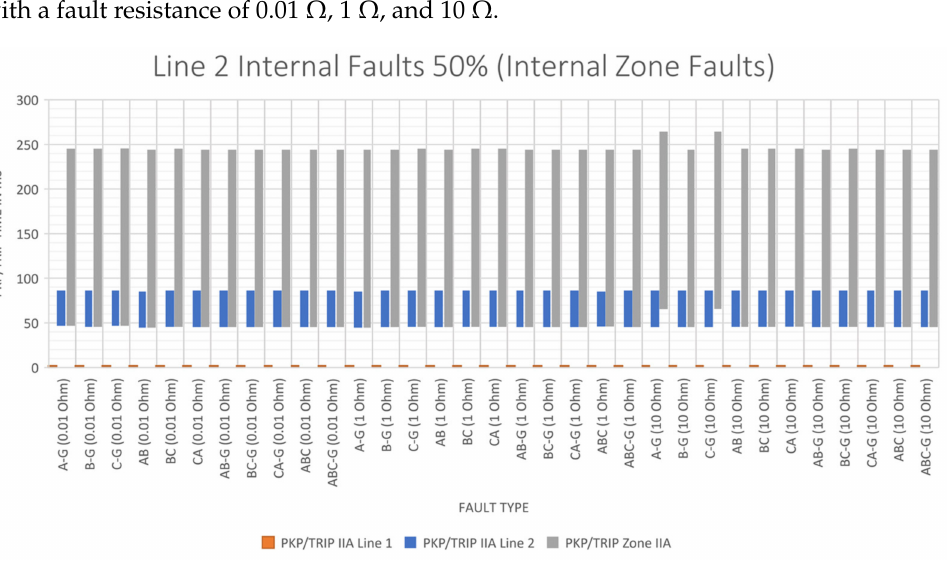
Figure 28. Internal line faults in Line 2 (50%); two